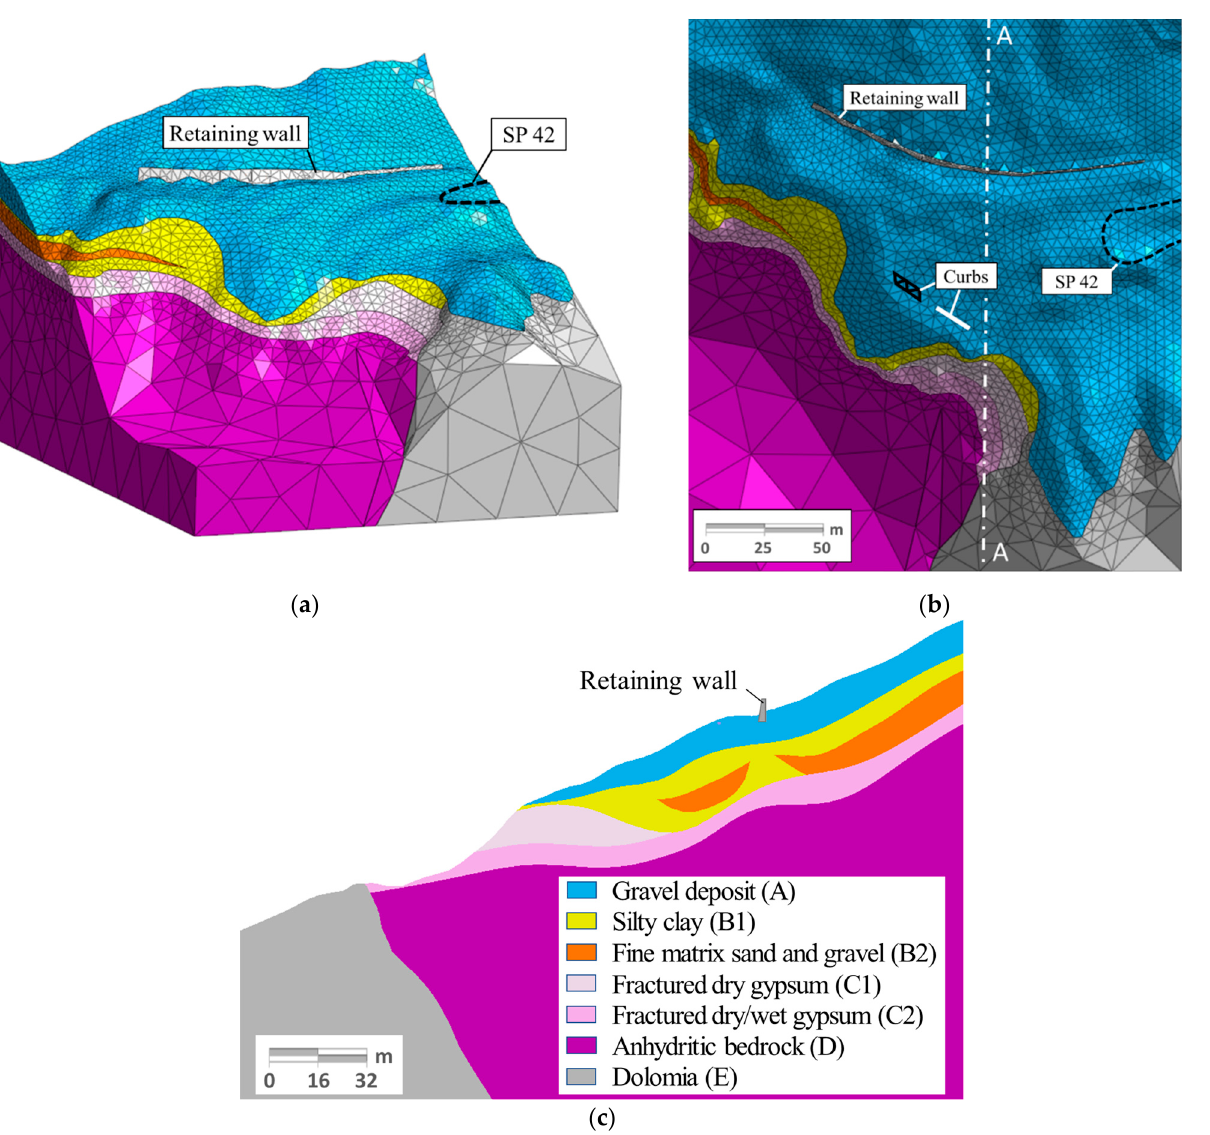
Figure 5. ( a ) Three-dimensional (3D) FEM model geometry; ( b ) planimetric view with the position of some reference points; ( c ) section A–A of the